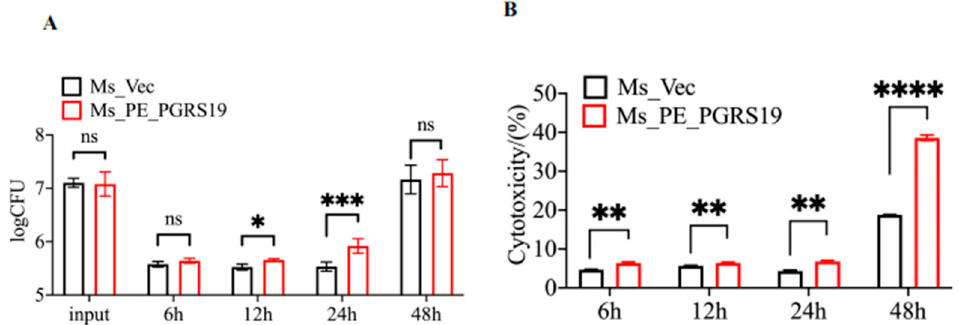
Figure 2. PE_PGRS19 strengthened the intracellular survival of Mycobacterium smegmatis and host cell toxicity. ( A ) The intracellular survival rate after infecting J774A.1 cells with Ms_PE_PGRS19 and Ms_Vec was estimated by counting CFUs at 6, 12, 24 and 48 h. ( B ) Cell toxicity was estimated by measuring LDH secretion in the supernatant of Ms_PE_PGRS19- and Ms_Vec-infected J774A.1 cells at 6, 12, 24 and 48 h. Multiple t -tests and 2-way ANOVA analyses were performed using the Holm–Š í d á k method. Data presented as x ± SD of three independent experiments. ns p > 0.05, * p < 0.05, ** p < 0.01, *** p < 0.001, **** p <